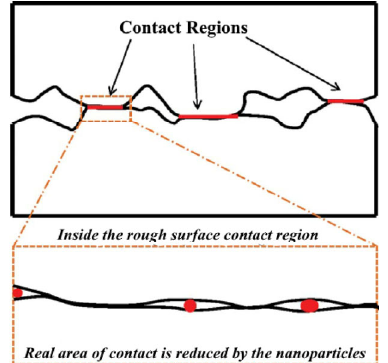
Fig. 7 Mechanism of reduction of the real area of contact by